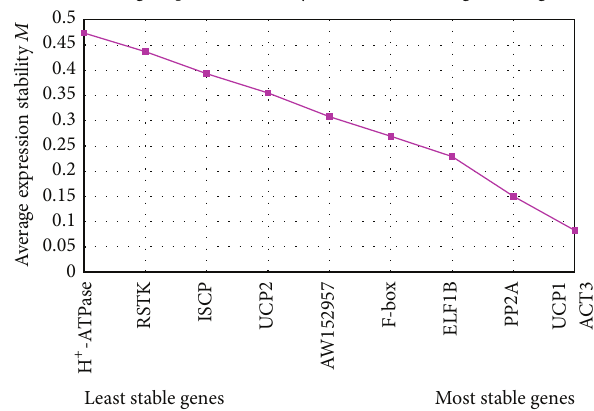
Figure 3: Expression stability ( 𝑀 ) and ranking of ten candidate reference genes after two soybean cultivars were exposed to different Cdconcentrationsfortwotimecourses. 𝑀 valueswerecalculatedby geNormfollowingstepwiseexclusionoftheleaststablegene(highest 𝑀 value) across all 24 samples.